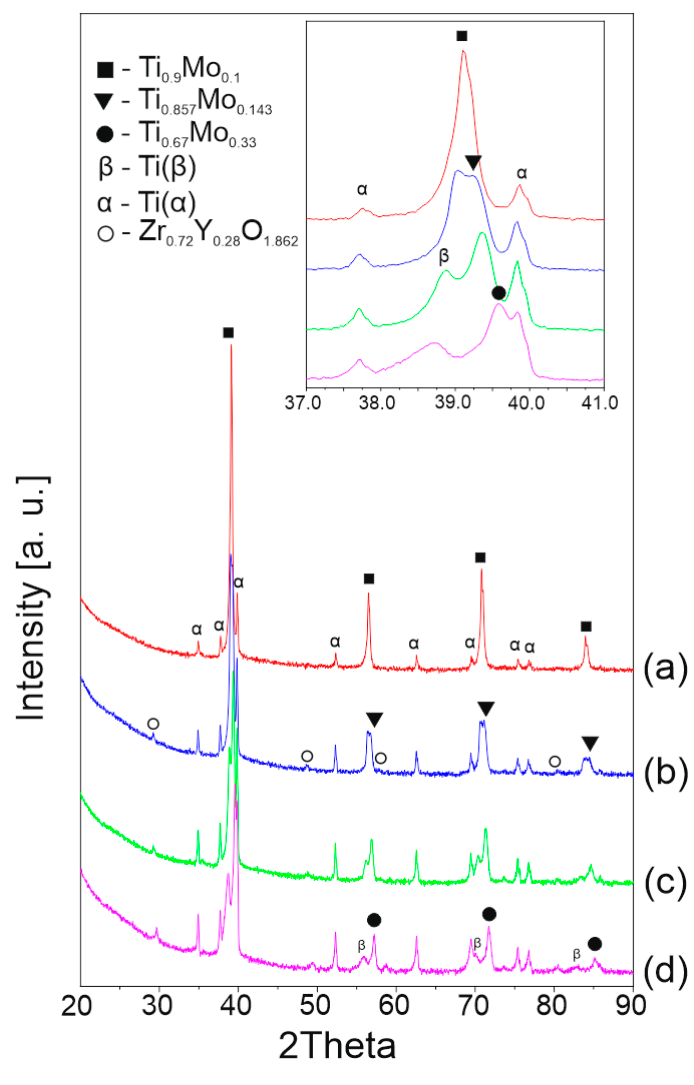
Figure 5. XRD patterns of 23 ( a ), 23–3 ( b ), 23–5 ( c ), 23–10 ( d ) after sintering.